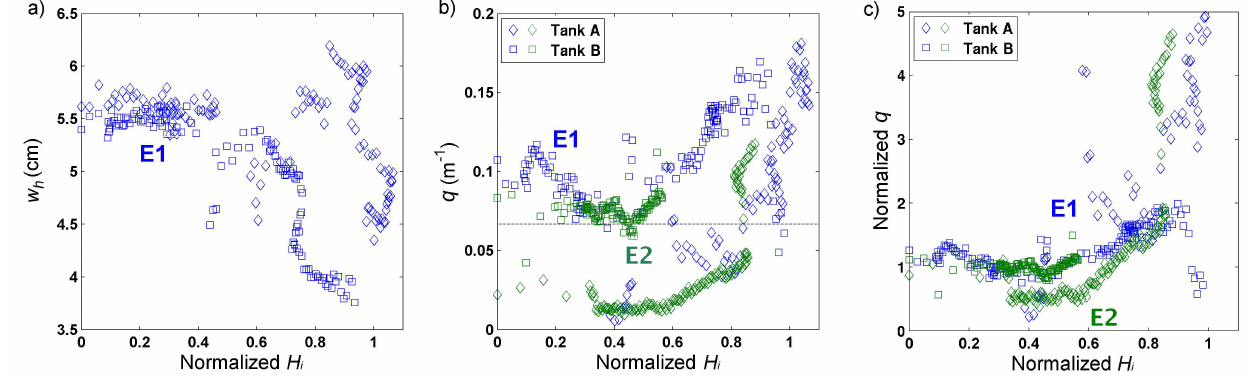
Fig. 9. Scatter plot of (a) wave height (b) attenuation rate and (c) normalized attenuation rate against the mean normalized ice thickness. (a) Displays data for E1 only (b) and (c) show data for E1 (blue) and E2 (green). Squares represent data for tank A, diamonds represent data for tank B. Wave height and ice thickness data from both sensor groups were averaged before plotting. The dashed black horizontal line in (b) is the natural scale of the tank (1/ L